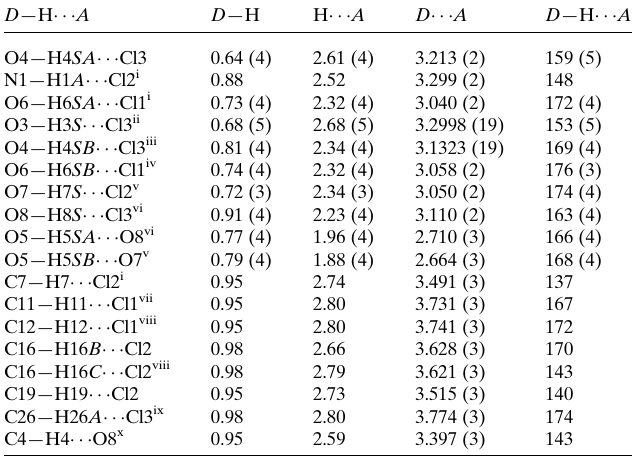
Table 2 Hydrogen-bond geometry (A˚ , (cid:3) ) for the Tb III complex.